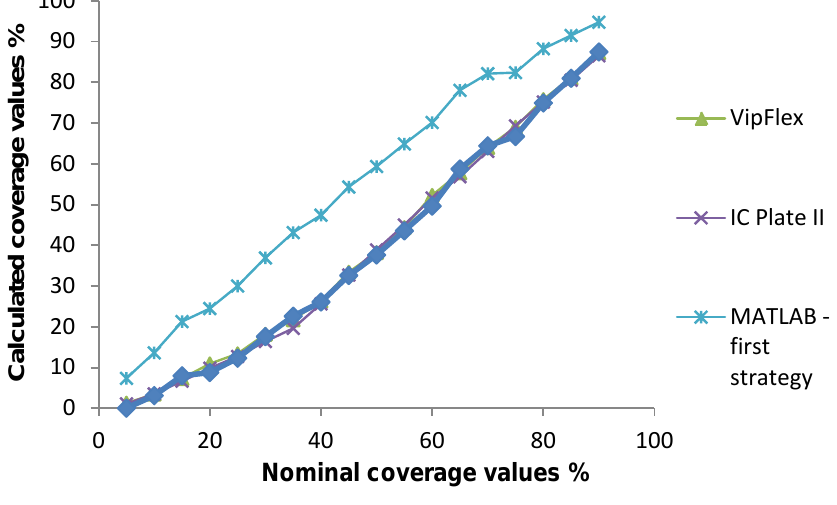
Figure 17. Comparison of nominal and measured coverage values obtained with different